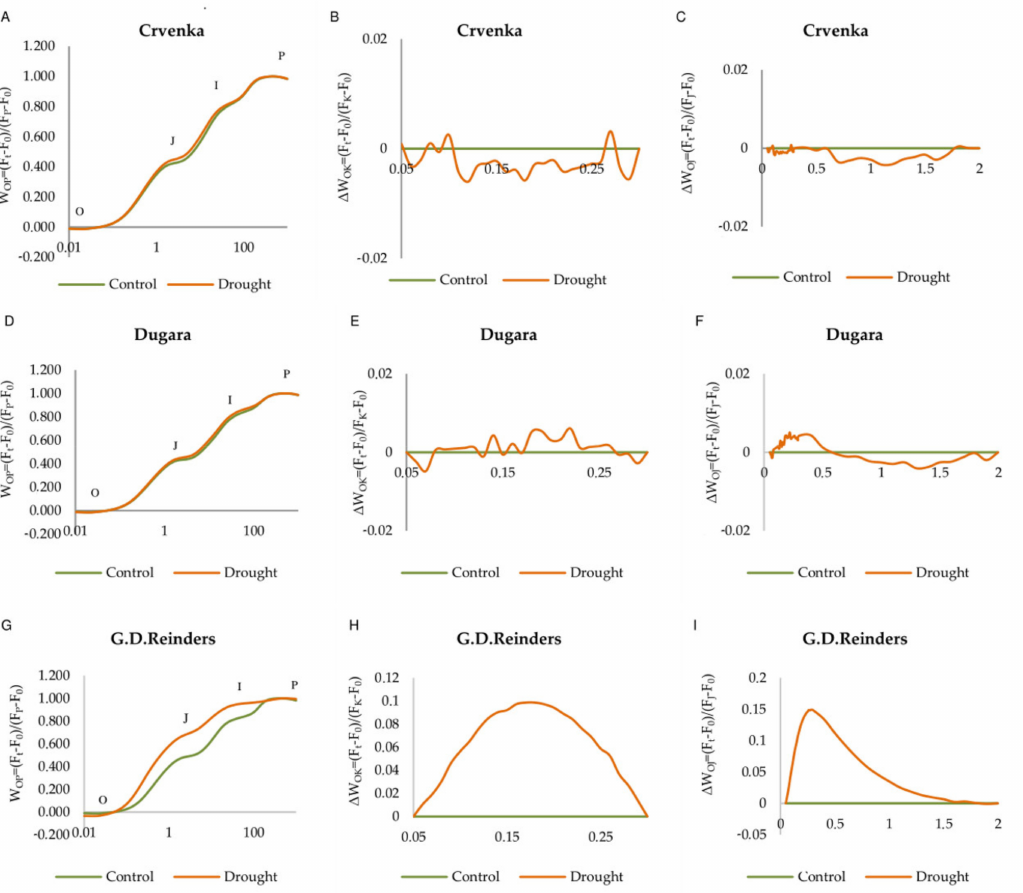
Figure 3. Chlorophyll a fluorescence OJIP transient curves of leaves of three apple cultivars submitted for 12 days to drought stress. Transients curves were normalized between O and P steps: W OP = (F t − F 0 )/(F P − F 0 ) ( A , D , G ). The difference kinetics ∆ W OJ ( C , F , I ) reveal the K-band; ∆ W OK ( B , E , H ) reveals the L-band. ∆ W OJ [ ∆ W OJ = V OJ(treatment) − V OJ(control) ] and ∆ W OK [ ∆ W OK = V OK(treatment) − V OK(control) ] were calculated from the comparisons of the stressed and control plants. Mean values ( n =